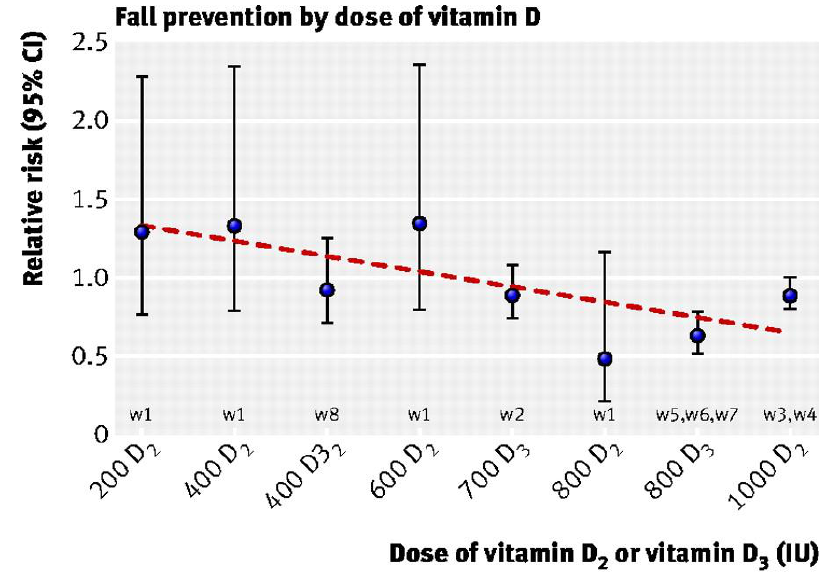
Figure 1. Fall prevention by dose and achieved 25(OH)D concentrations. Circles represent relative risks and error bars represent 95% confidence intervals. Trendline is based on w5 w6 w7 , so the effect series of effect sizes (circles). There were three trials with 800 IU D 3 size for 800 IU D is the pooled result from these three trials. Likewise, the effect size for 3 w3 w4 . We have listed 1,000 IU D is the pooled result from the two trials with 1,000 IU D 2 2 the same dose D and D separately in the graph to account for their potential different 2 3 impact on fall reduction. As there were two data points from the Broe et al. [37] trial that reached 48 nmol/L w1 , two trials that reached 60 nmol/L w1 w3 and two trials that reached 66 nmol/L w6 w7 , we pooled each of the sets. On the basis of visual inspection of Figure 1, the benefits of vitamin D for fall risk started at a dose of 700 IU a day. Reproduced from Bischoff-Ferrari et al. [35], with permission from BMJ Publishing Group